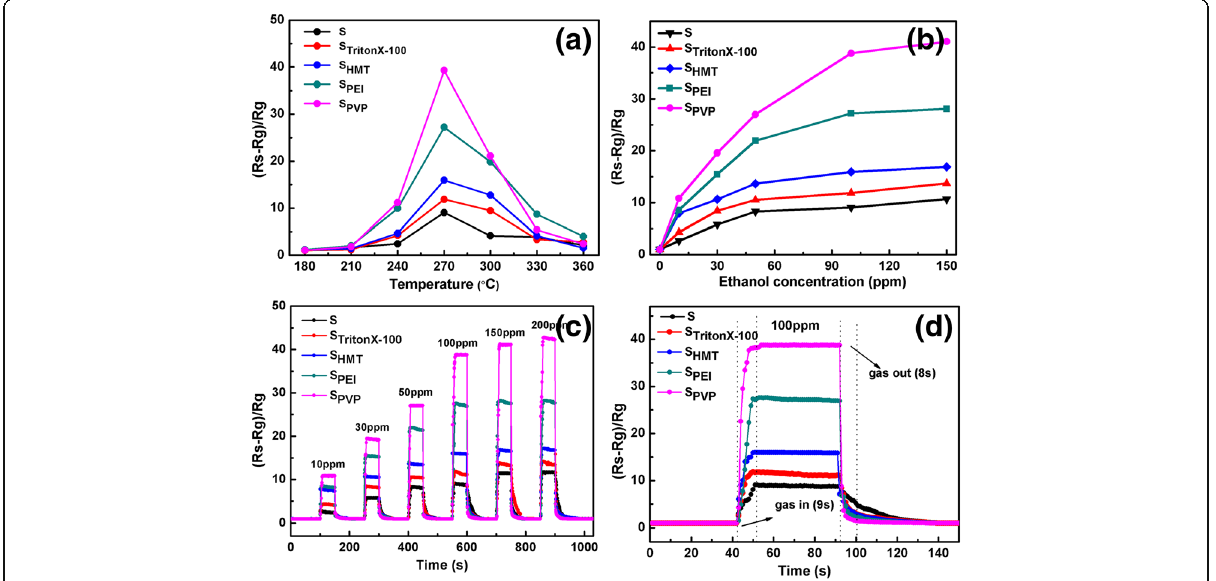
Fig. 6 a The response of the sensors to 100 ppm ethanol under different operating temperatures (180 – 360 °C). b The dynamic response curves of the sensors to ethanol with different concentrations (10 – 150 ppm) at 270 °C. c Response versus time curves of the sensors to 10 – 200 ppm ethanol consecutively at 270 °C. d Dynamic sensing transient of the sensors to 100 ppm ethanol at 270